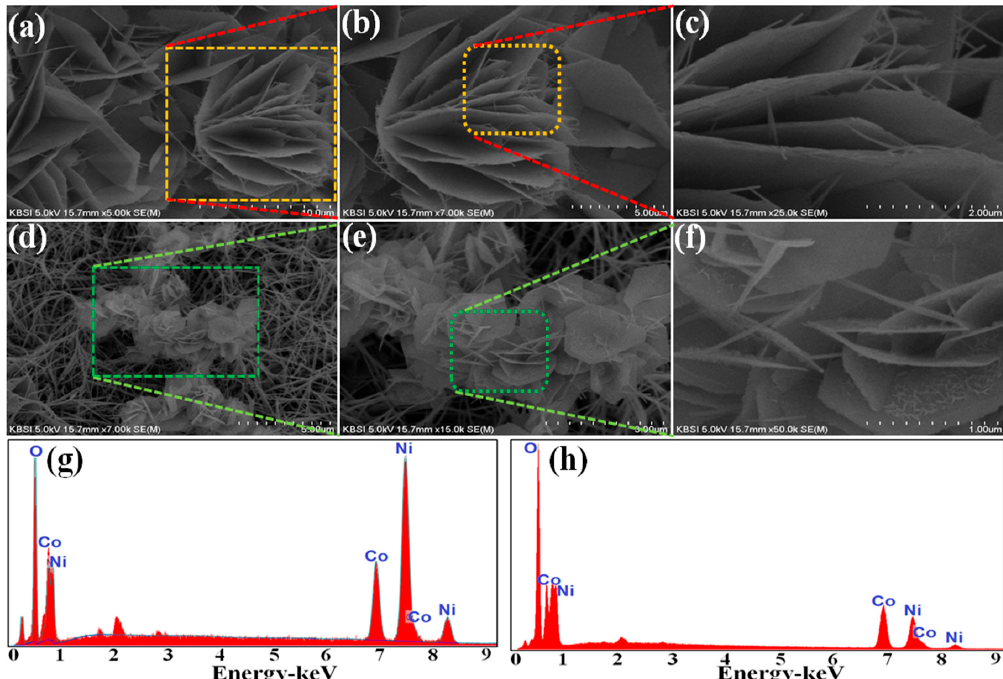
Figure 1. Morphological characterization of NF@NCO/NCO nanofile arrays (NFAs) and NF@NCO nanoleaf arrays (NLAs). FESEM images of the prepared NF@NCO/NCO NFAs ( a – c ) and NF@NCO NLAs ( d – f ) and their corresponding high magnification images and EDX data ( g ) and ( h ).